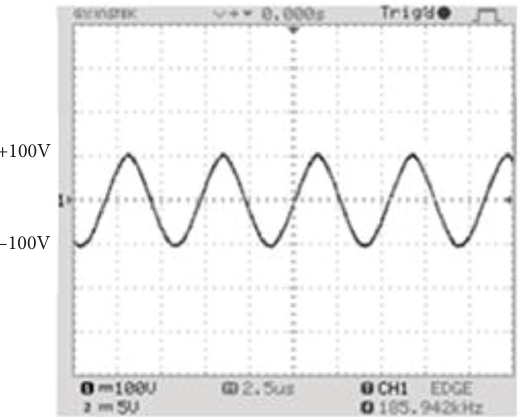
� 50V. Figure 21: Output voltage waveform when − V dc